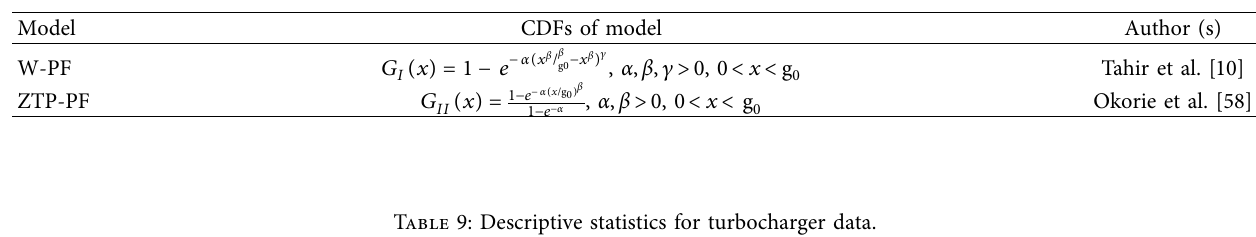
Table 8: List of some competitive models of CDFs.